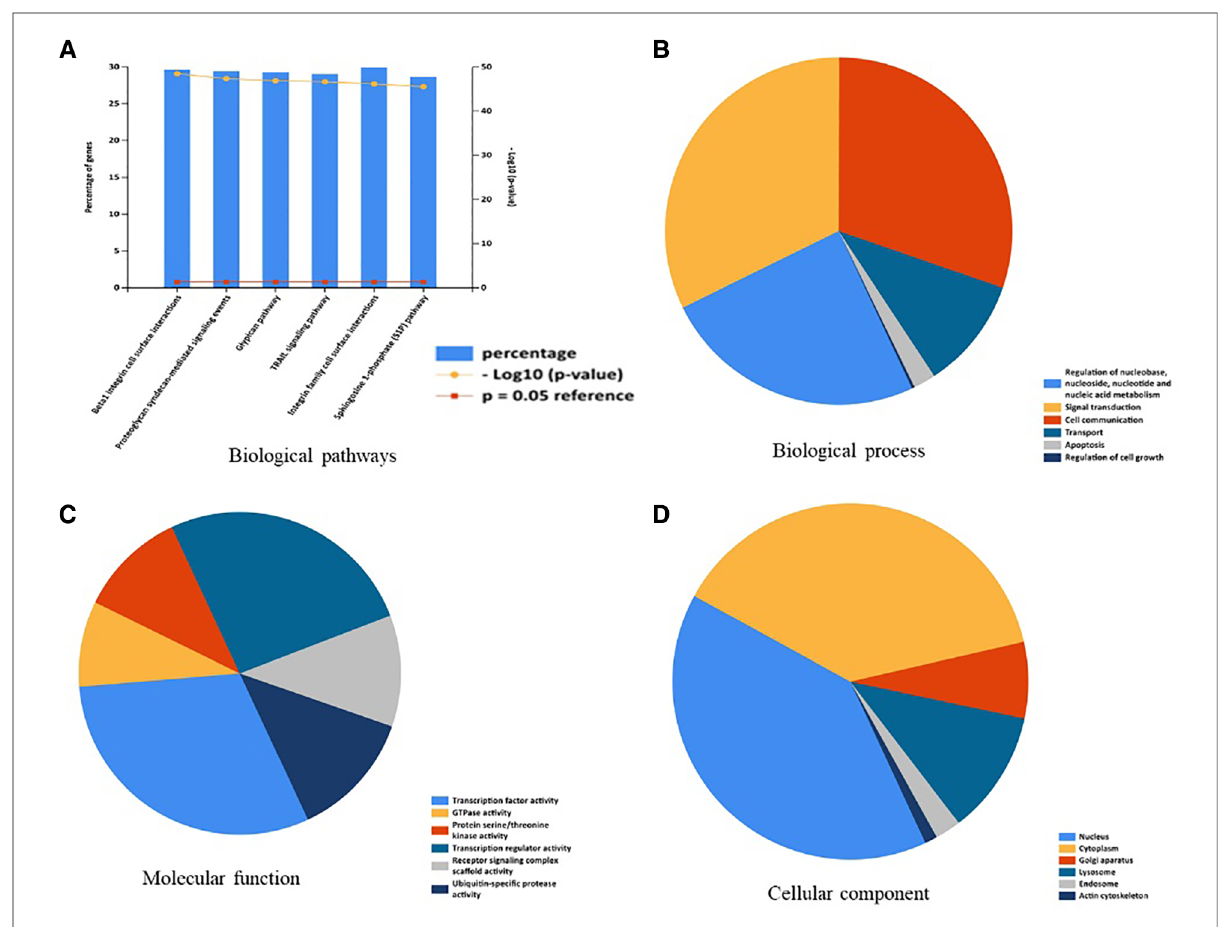
FIGURE 1 Enrichment analysis of OA-related miRNAs. ( A ) Biological pathways were analysis by Funrich. ( B ) Biological process was analysis by Funrich. ( C ) Molecular function was analysis by Funrich. ( D ) Cellular component was analysis by